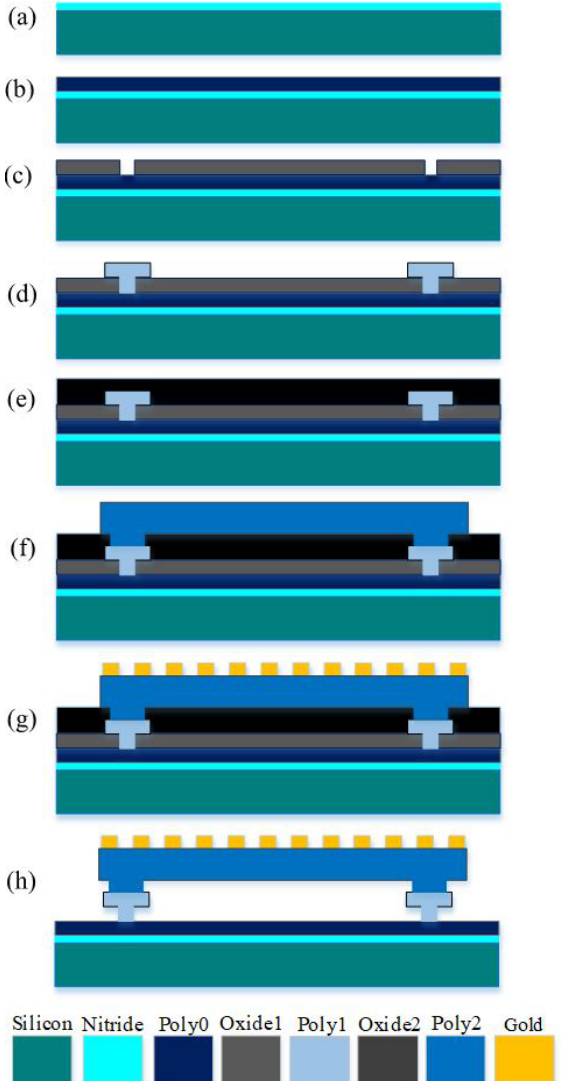
Figure 5. Cross-sectional view of the PolyMUMPs technology for the fabricated device shows ( a ) a silicon nitride deposition, ( b ) first polysilicon layer, ( c ) first sacrificial layer, ( d ) second polysilicon layer, ( e ) second sacrificial layer, ( f ) third polysilicon layer, ( g ) metal (Gold) layer deposited and ( h ) a final released